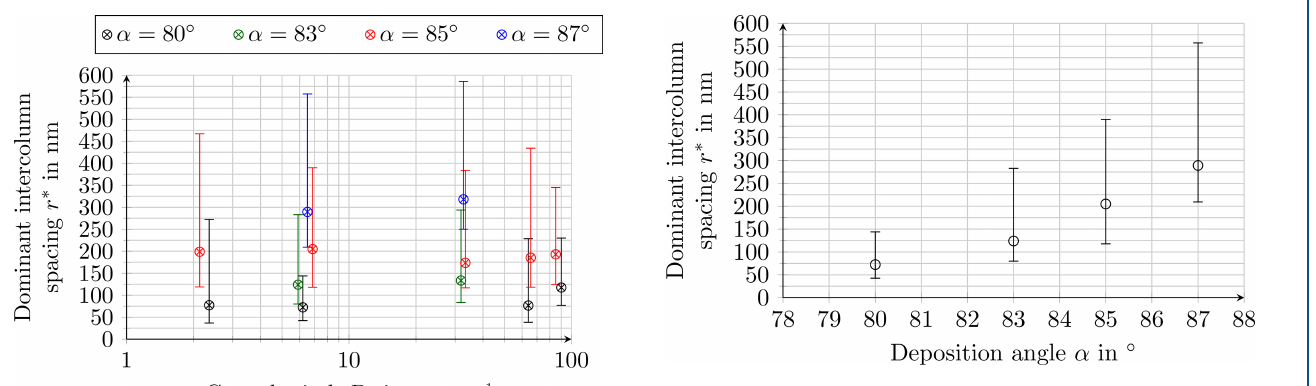
Figure 6. Dominant intercolumn spacing r ∗ versus deposition an- gle α . The bars show the range of variation as related to growth